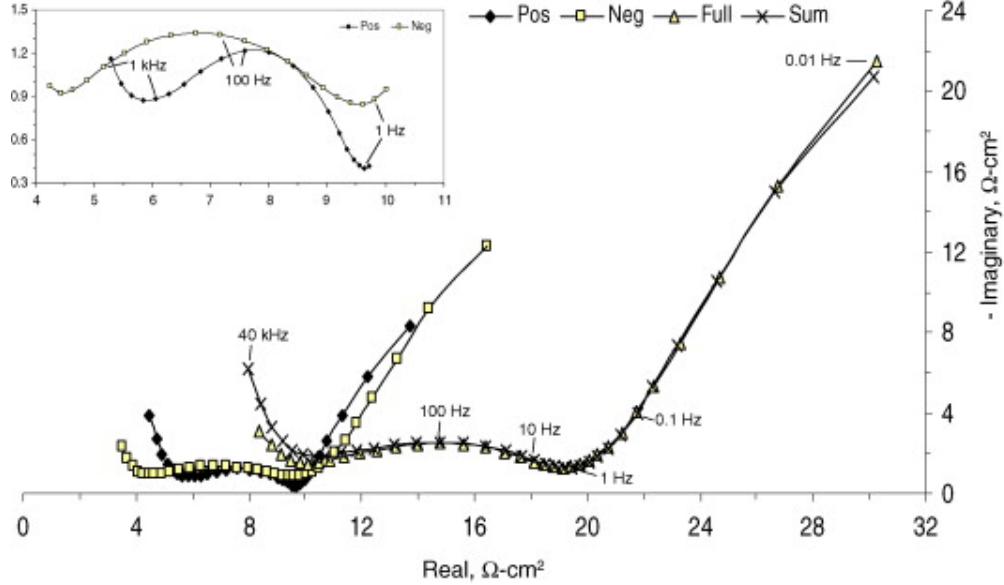
Figure 5. Impedance data measured at 3.72 V, which is the full voltage. The illustration inserted is an extended view of the respective electrode data [42]. Reprint with permission [42]; Copyright 2004, Elsevier.